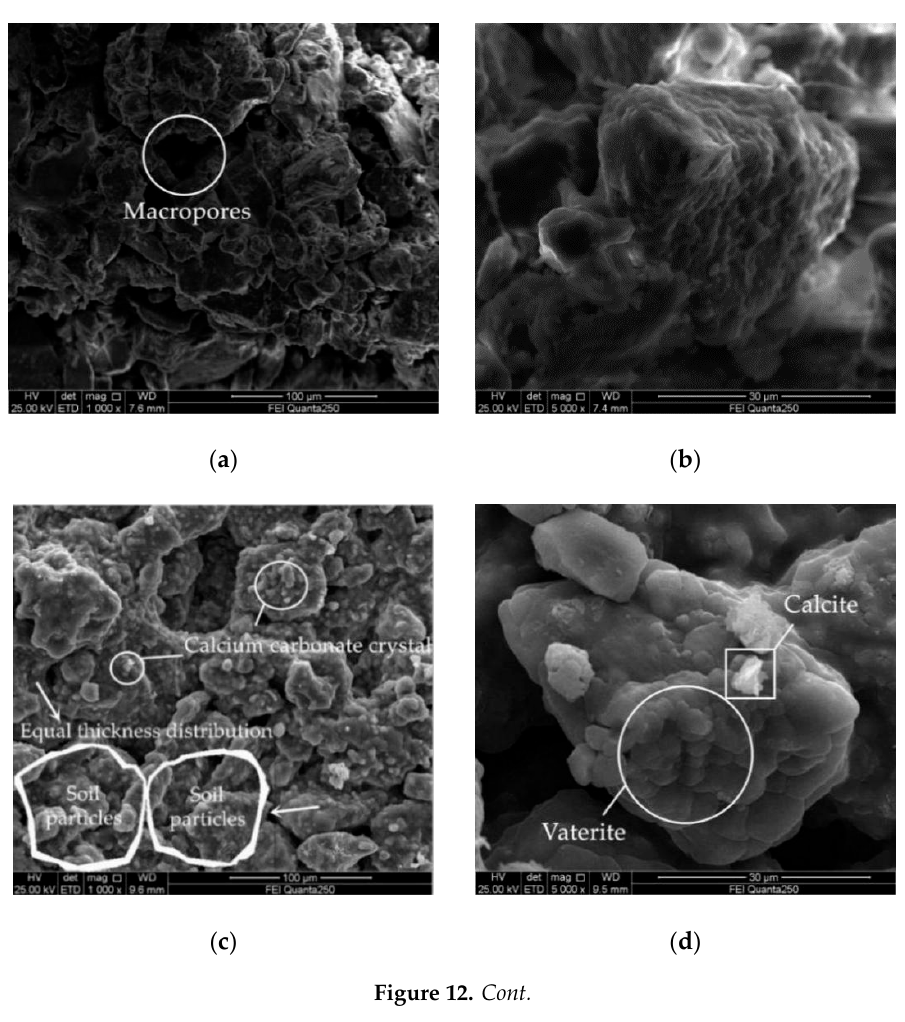
Figure 11. Images of soil under a USB hand-held digital microscope: ( a ) untreated and ( b ) EICP + glutinous rice